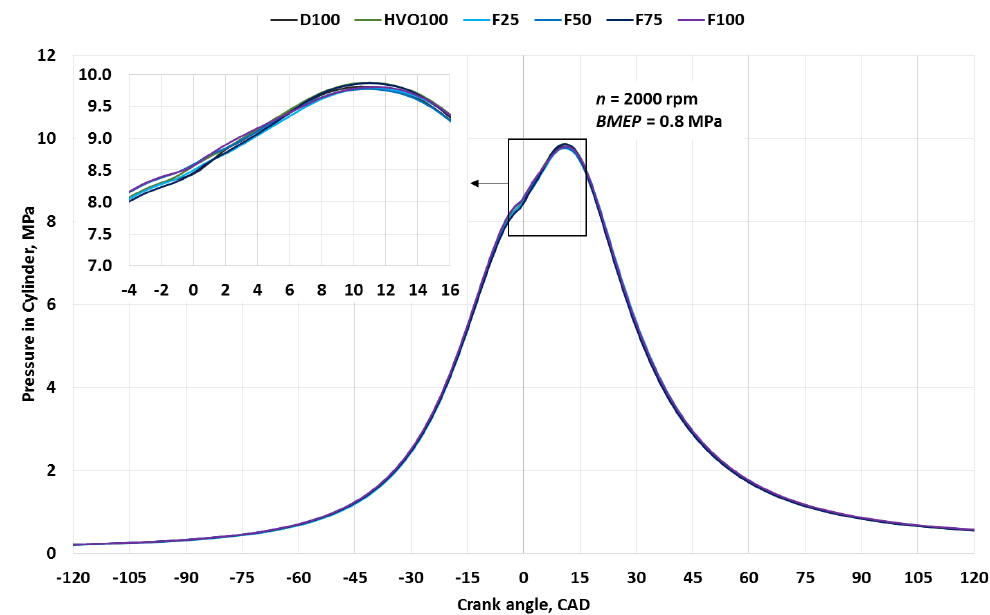
Figure 6. Dependence of the pressure in the cylinder using different fuels.